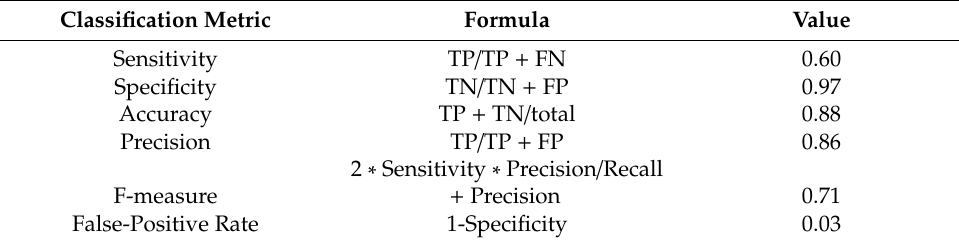
Table 4. Classification metrics for OpTIS cover crop.